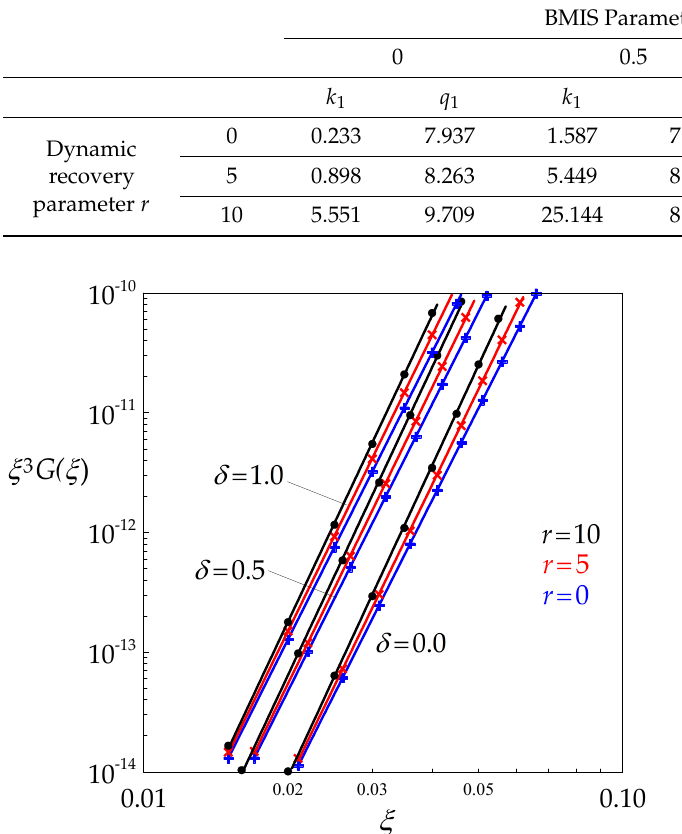
Figure 2. Double logarithmic diagram highlighting the power law dependence of ξ 3 G ( ξ ) with respect to ξ for various values of r and δ .